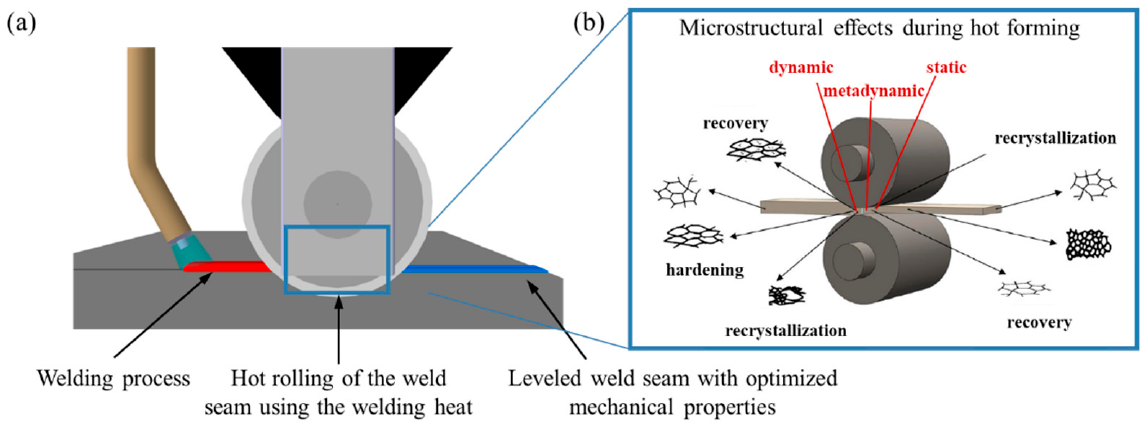
Figure 1. ( a ) Principle of process combination welding and forming. Welding process (left side), (hot) rolling of the deposited material (frame in the middle area), deformed weld bead (right side). ( b ) shows the microstructural effects caused by induced heat and/or plastic strain (Reprinted from Ref. [4].